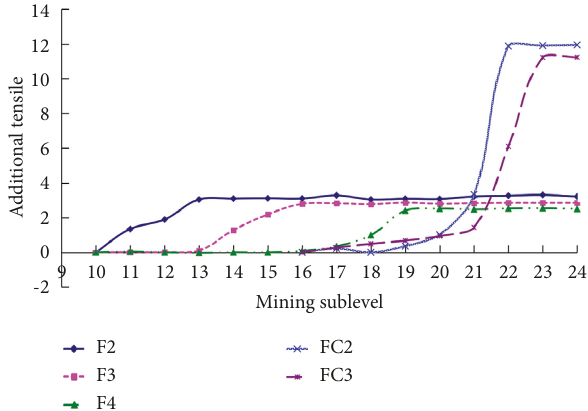
Figure 23: Temporal and spatial relationship curve of additional tensile stress on each fault plane with mining depth.